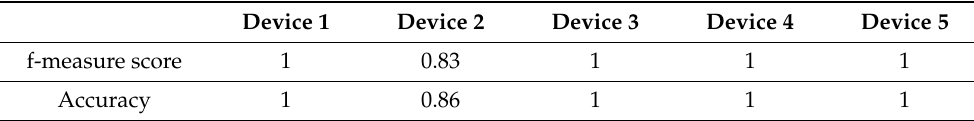
Table 3. Performance of SC-EV algorithm on ideal data.